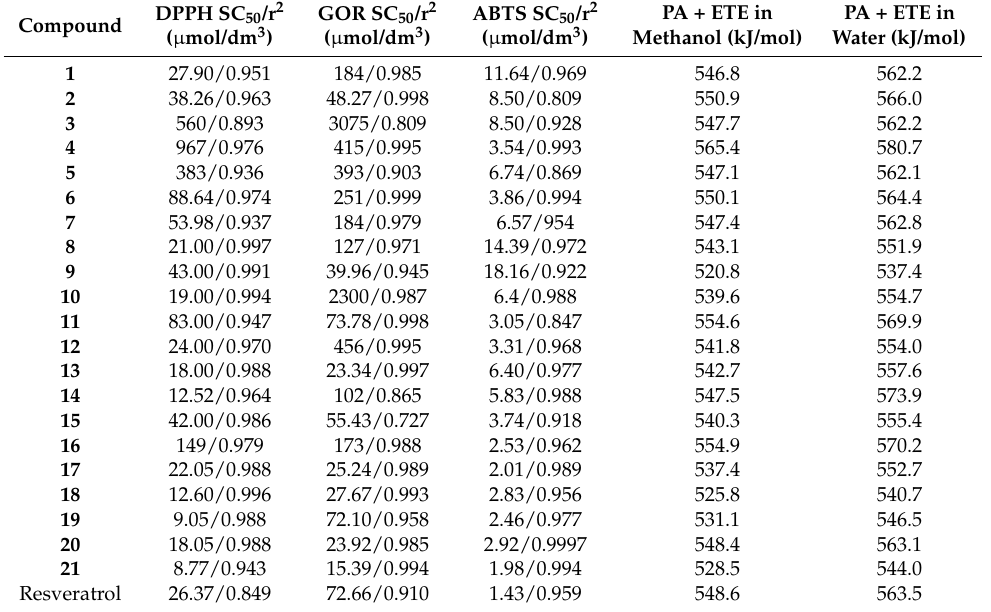
Table 1. SC 50 and proton affinity (PA) + electron transfer enthalpy (ETE) values of studied (hydroxy